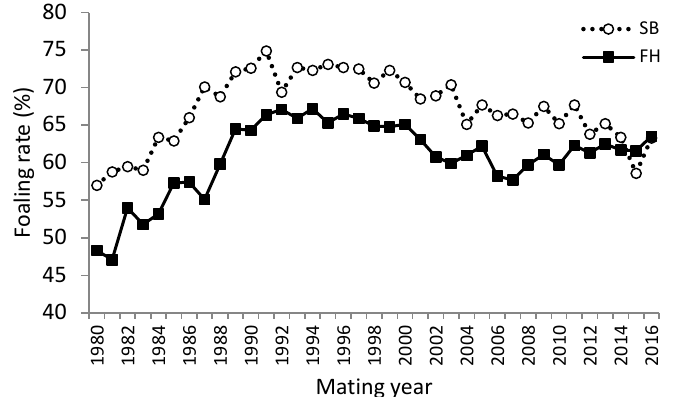
Fig. 1. Foaling rates for Standardbreds (SB) and Finnhorses (FH) from